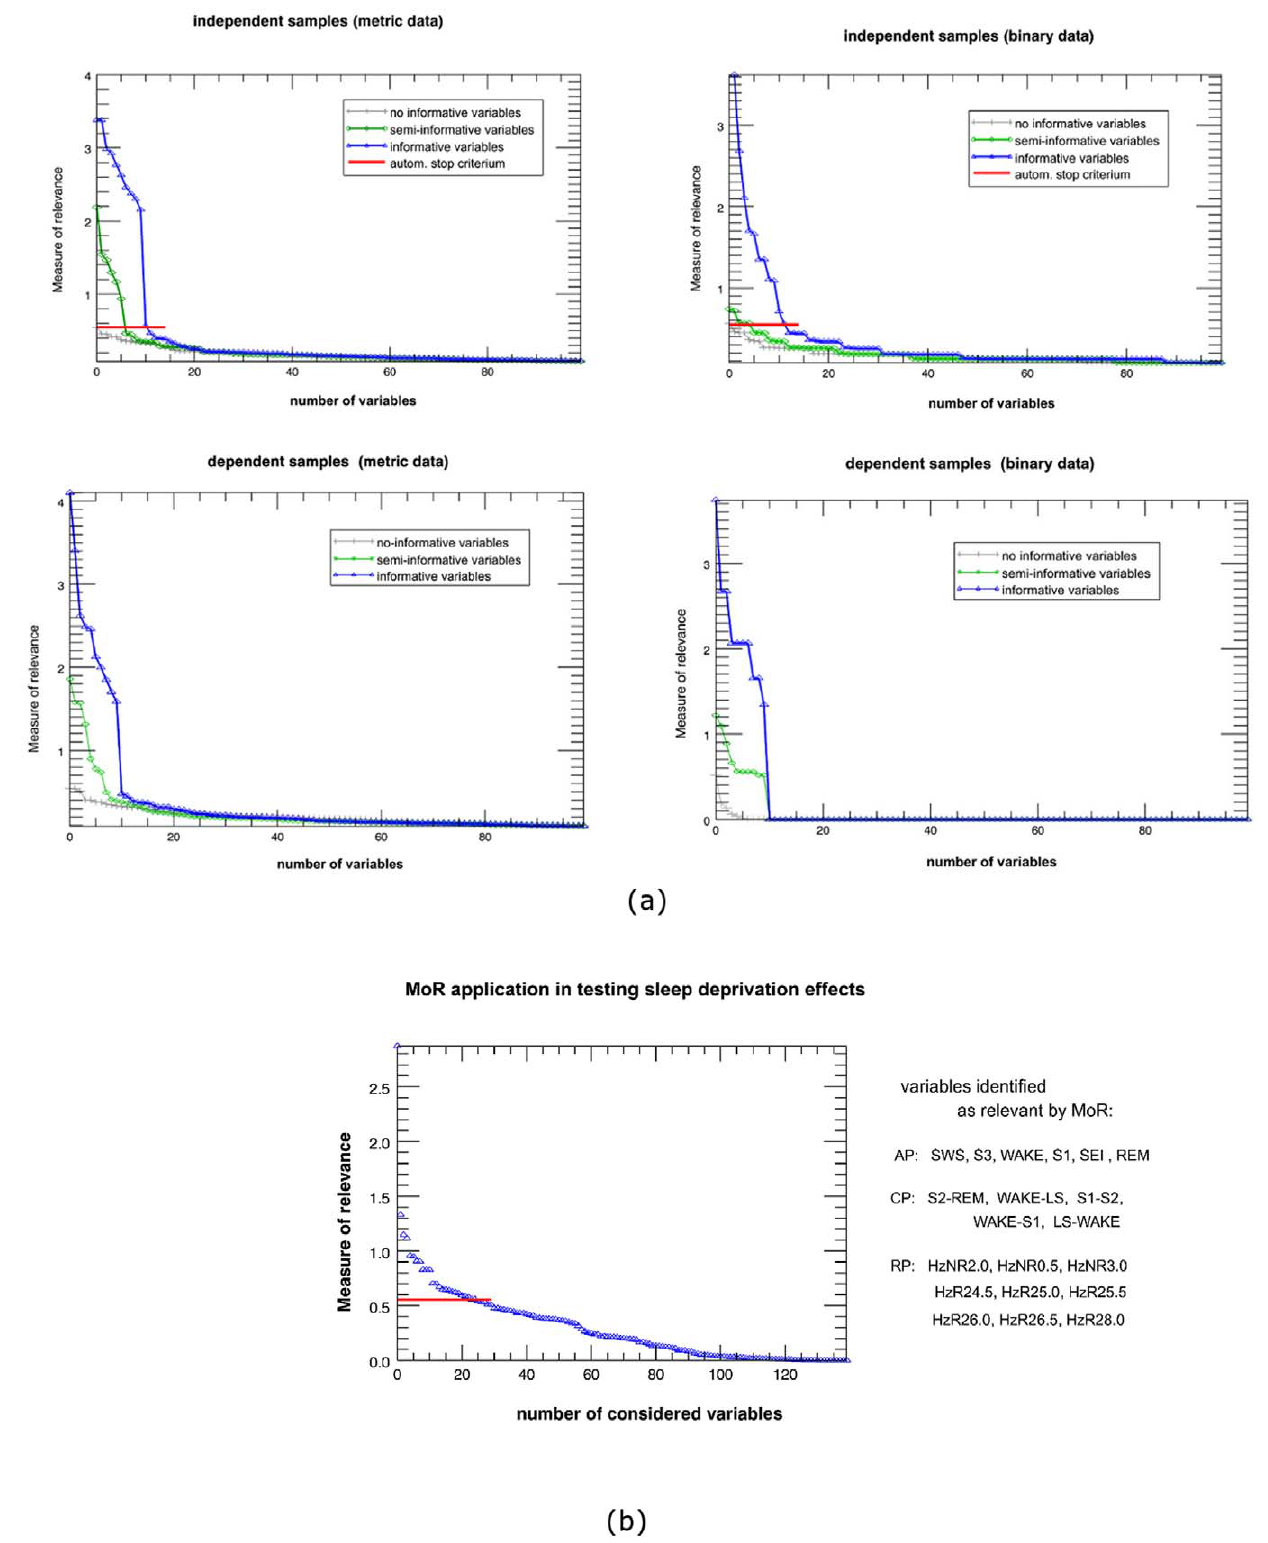
Figure 2. Measure of relevance for simulated and authentic data. (a) Courses of the best 100 MoR-values by simulating a two-sample problem with 1,000 variables of different data types and sample designs. For each variable and each sample n ~ 15 pseudo random numbers following a certain distribution (see more details in text) were drawn. The three lines correspond to situations with 10 high-informative, semi- informative or non-informative variables among the considered 1,000 variables, respectively; all other (990) variables were non-informative. Irrespective of data type and sample design the 10 informative variables (blue lines) were correctly identified with MoR . As expected the semi-